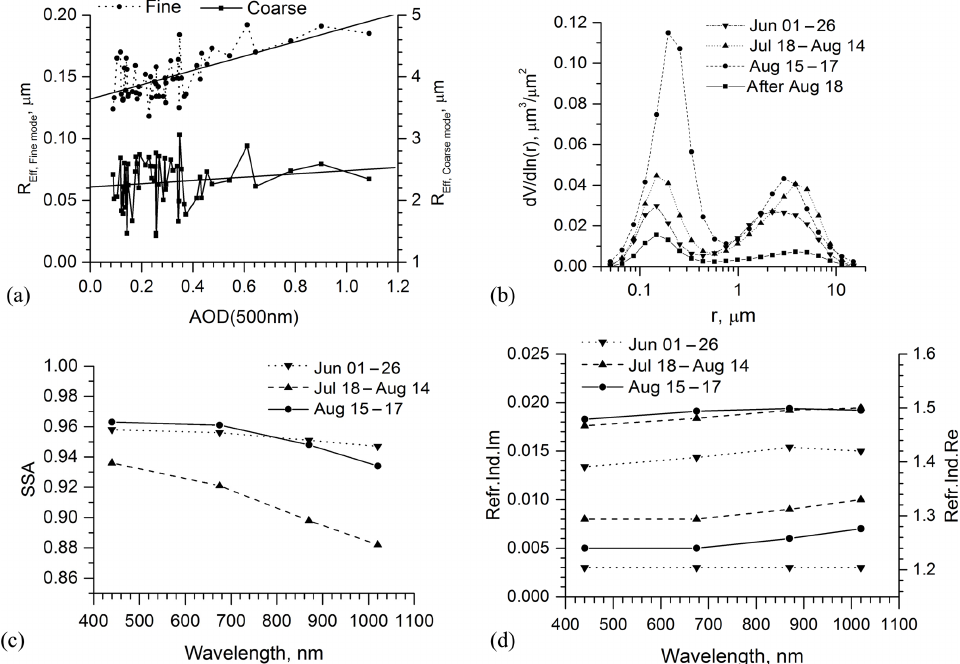
Figure 6. Aerosol spectral SSA and microphysical properties from AERONET measurements at the Kyiv site during summer 2010: (a) par- ticle effective radius versus AOD for fine (left axis, top curves) and coarse (right axis, bottom curves) modes averaged for the entire summer 2010; (b) particle size distribution; (c) spectral SSA; (d) spectral RI, real (right axis, top curves) and imaginary (left axis, bottom curves) parts. Representative periods are 1–26 June (triangles down), 18 July–14 August (triangles up), 15–17 August (circles), and 18–31 August